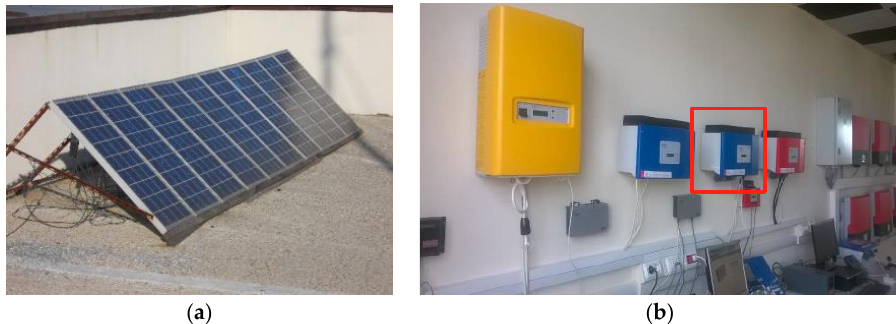
Figure 4. The components of the subsystem 1: ( a ) 10 photovoltaic panels; and ( b ) the Sunny Boy SB2100TL inverter.